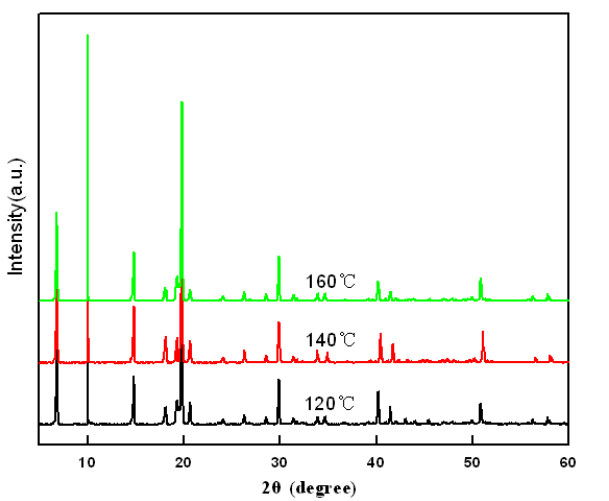
Figure 1: XRD of the crystal MOF-5.